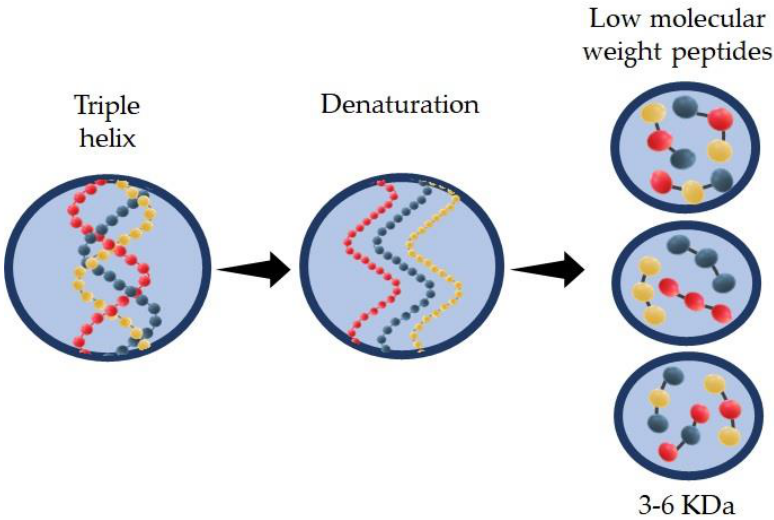
Figure 1. Denaturation of native collagen into small low-molecular-weight peptides.